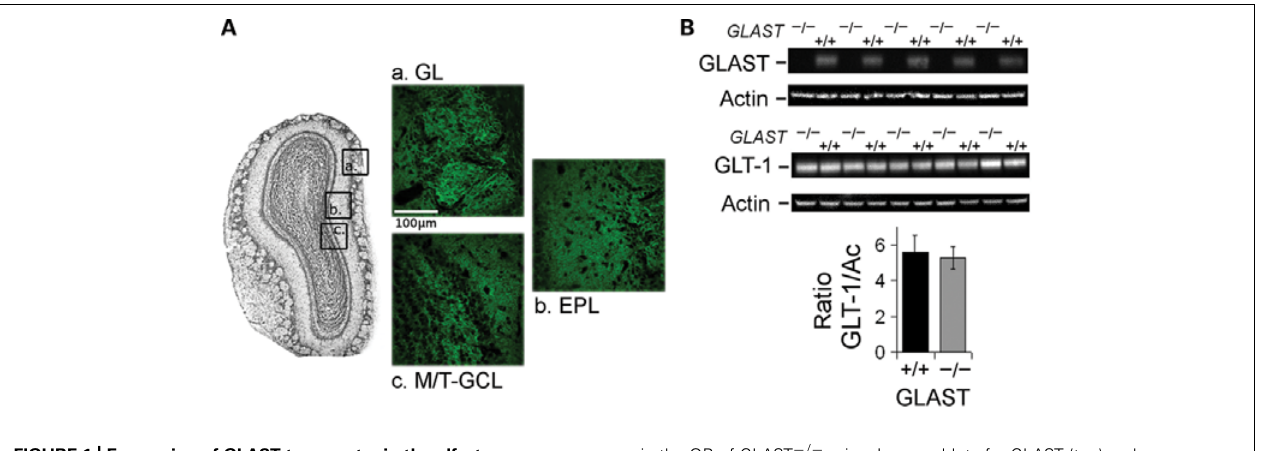
in the OB of GLAST − / − mice. Immunoblots for GLAST (top) and GLT-1 (bottom) in the OB of GLAST + / + and GLAST − / − mice. As seen on the bar graph, the averaged relative level of expression of GLT-1 is not different between GLAST − / − ( n = 5) and GLAST + / + ( n = 5 )